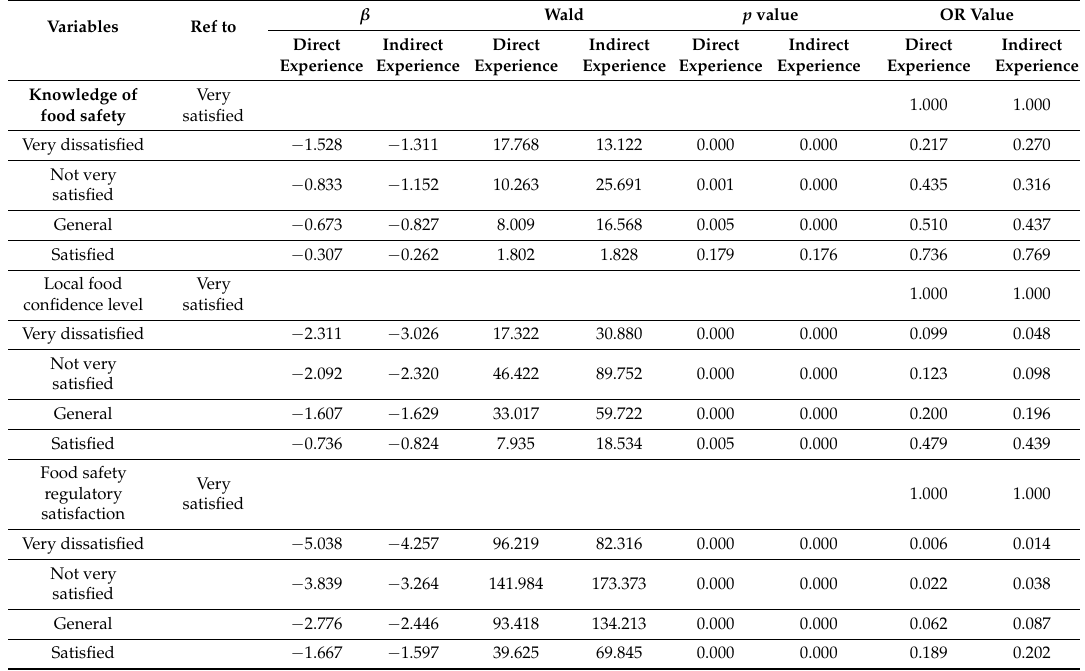
Table 6. Two types of consumers regulatory satisfaction model parameter estimation